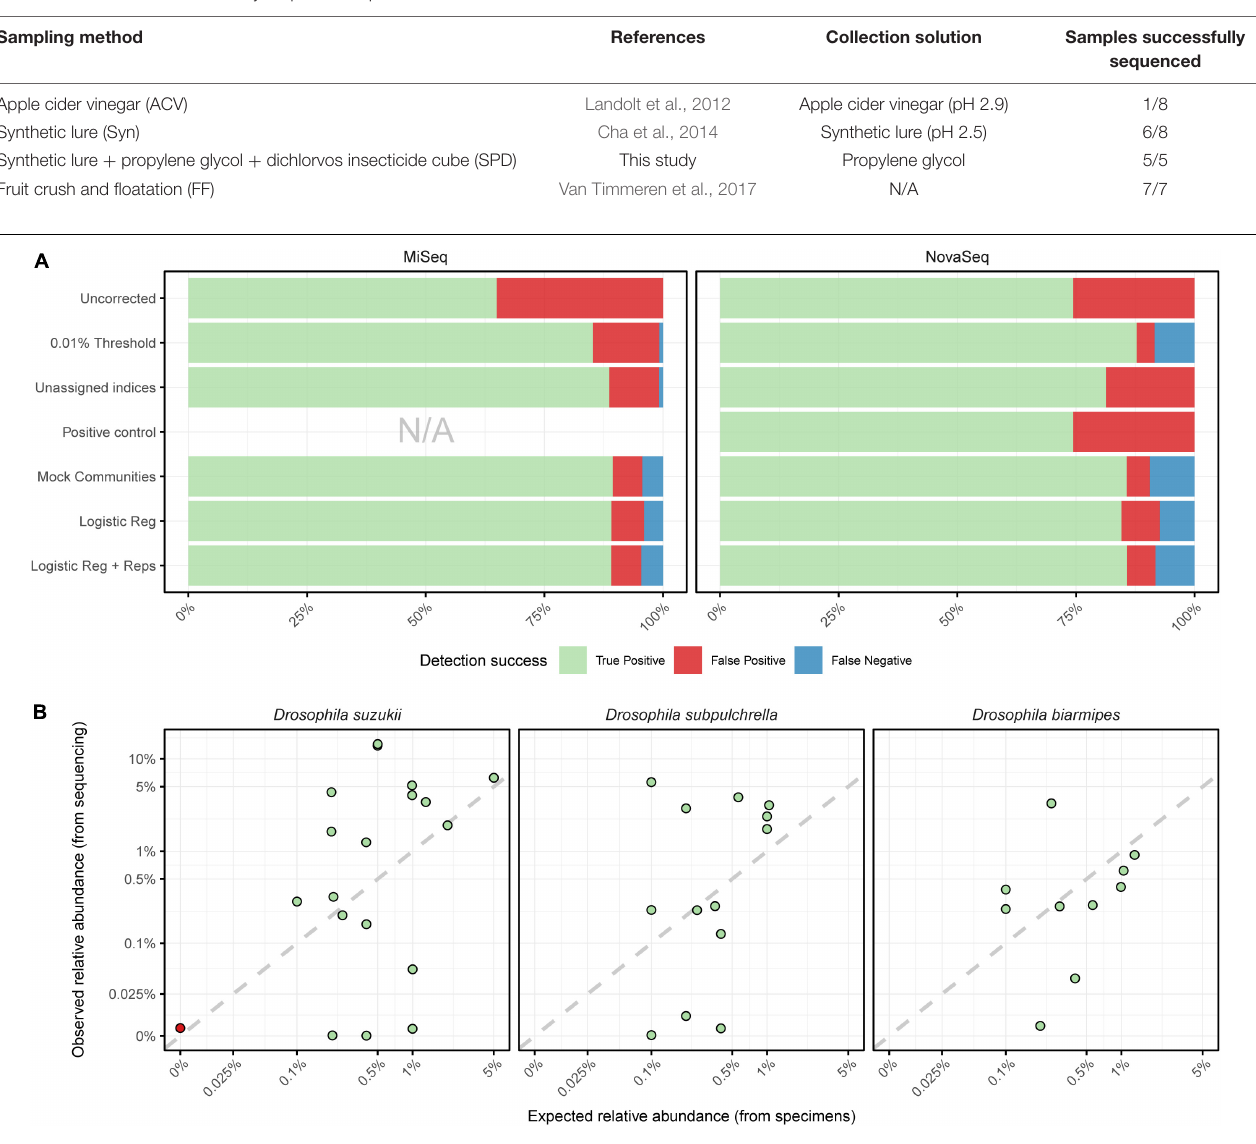
FIGURE 3 | (A) The proportion of true positives, false positives, and false negatives across both the MiSeq and NovaSeq runs following application of various methods for deriving a detection threshold. (B) Relationship between expected (from specimens) and observed (from sequencing reads) relative abundance for target species spiked into mock and trap communities, with each observation colored by whether it was classified as a true positive or false negative by the logistic regression model. Data is displayed on a pseudo-log scale to avoid compressing variation around zero, with dashed lines indicating a perfect relationship between expected and observed relative